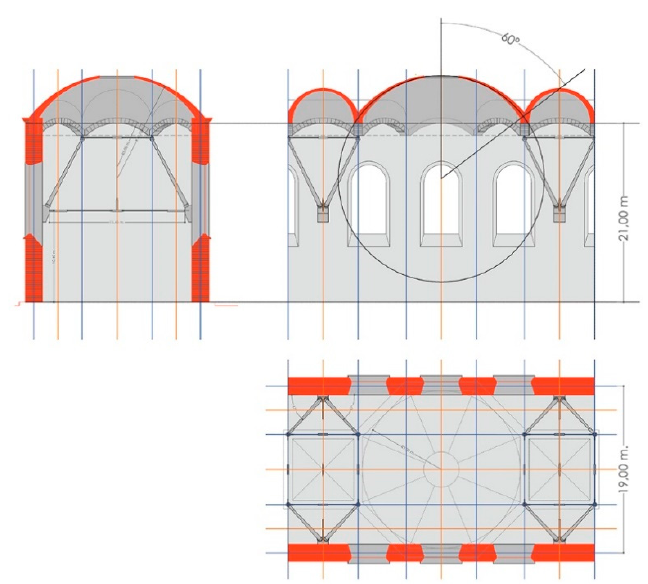
Figure 2. Geometric scheme used for the calculation from the original image.